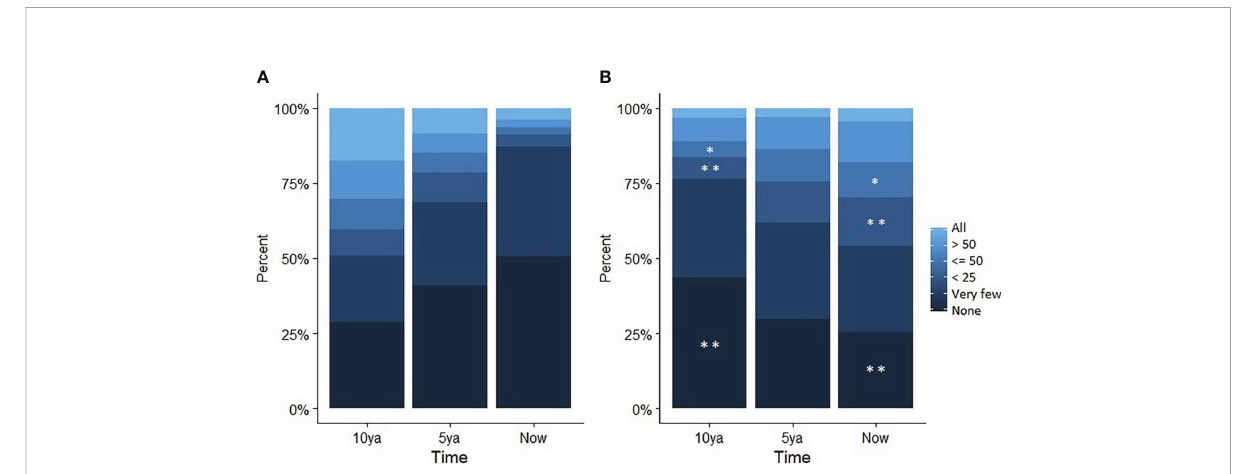
FIGURE 7 Changes in fi shers ’ perceptions of changing use over time (now, 5 years ago, and 10 years ago) for (A) hook-based gears, (B) electro fi shing. Color categories indicate proportion of local community that respondents thought used different gears now and in the past. For changing hook-based gear use, all years and all groups are signi fi cantly different; for changing electro fi shing use, asterisks indicate signi fi cant differences within same abundance categories between years at the 5% level (*) and 1% level (**).